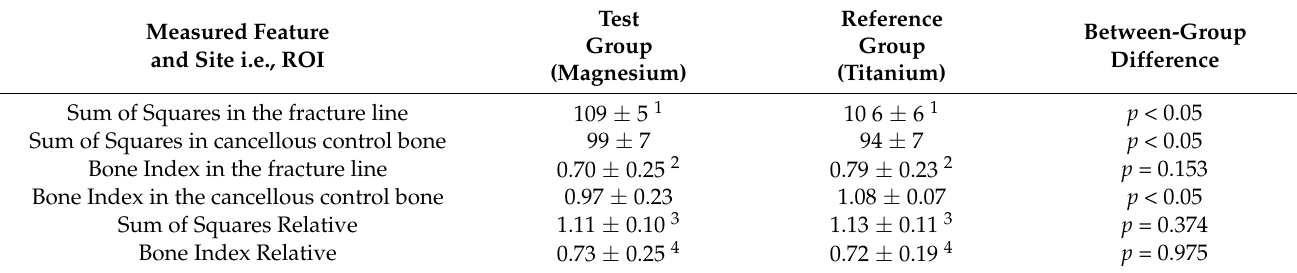
Table 4. Comparison of the fracture site 12 months post-operation by means of texture analysis with SumOfSqr and Bone Index